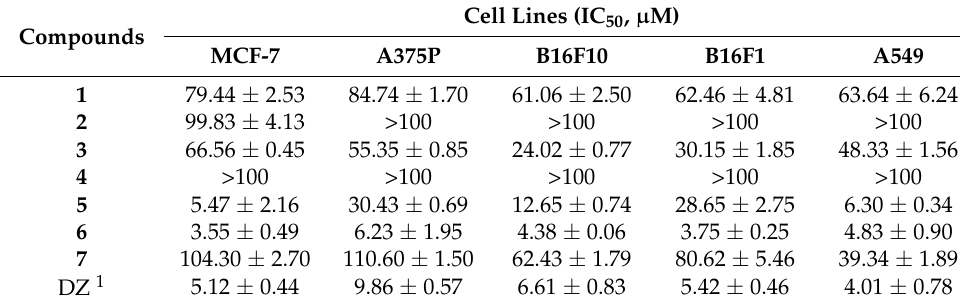
Table 1. Cytotoxic activities of compounds 1 – 7 against cancer cell lines. Compounds